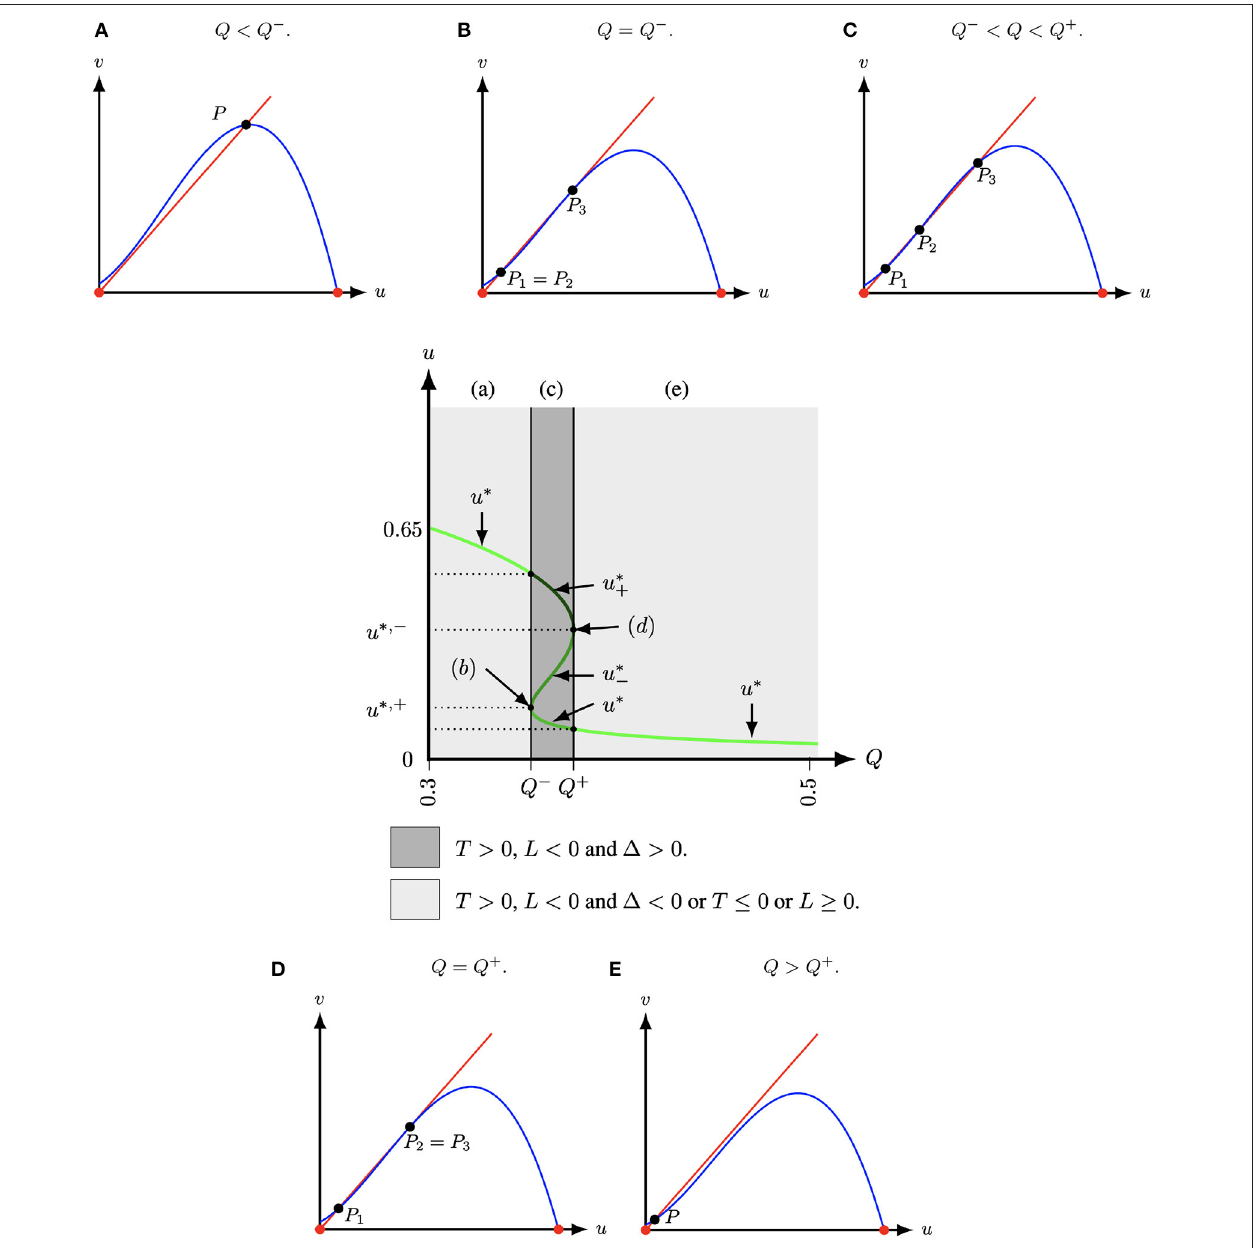
A M , (1 / 10, 1 / 10) fixed and with T 1 = − = − + √ 5) / 200, that Q ± : (73 = ± =